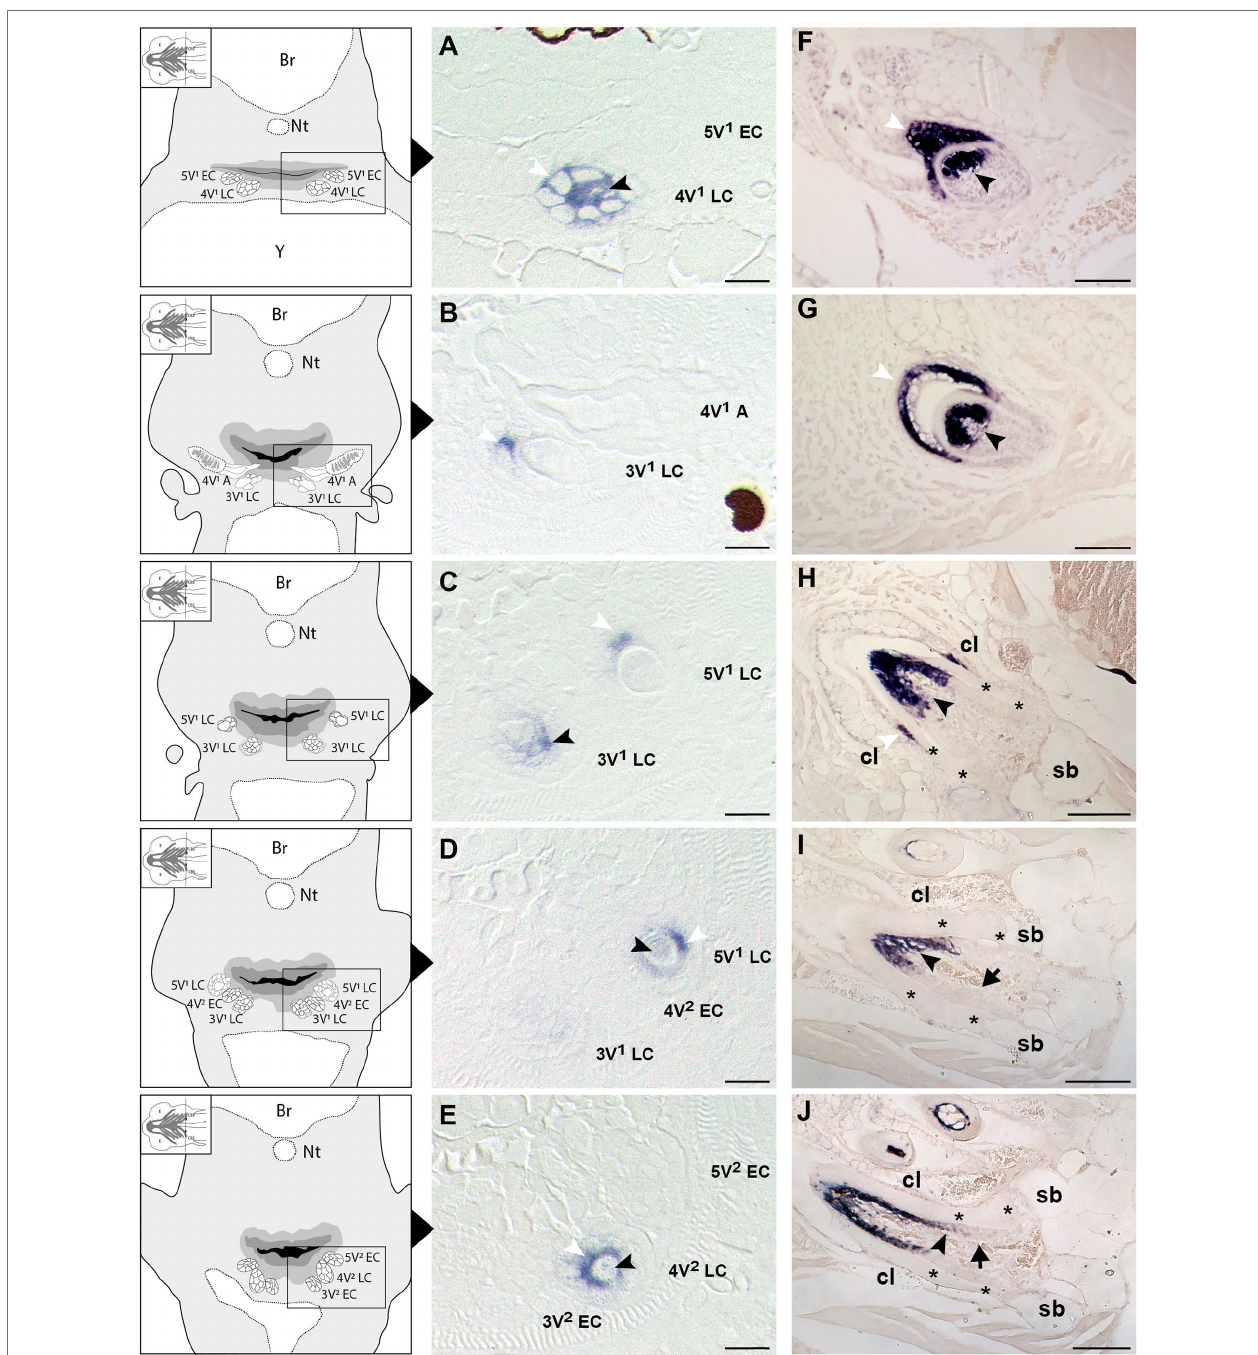
FIGURE 2 | Expression of secretory calcium-binding phosphoprotein 5 ( scpp5 ) during zebrafish tooth development. Transverse sections of zebrafish postembryonic stages (72–120 hpf – A–E ) and adults (F–J) in the region of the pharyngeal jaws, with explanatory schemes for postembryonic stages. At 72 hpf (A) the initiator tooth (4V 1 ) at LC stage expresses scpp5 in both ameloblasts and odontoblasts, whereas no expression is detected for the first-generation teeth 3V 1 and 5V 1 , still at EC stage. Between 80 (B) and 96 hpf (C) tooth 4V 1 , now attached, shows no expression of scpp5 , while 3V 1 and 5V 1 at LC stages start to express scpp5 in both ameloblasts and odontoblasts. Between 96 (D) and 120 hpf (E) the second-generation teeth (4V 2 , 3V 2 , and 5V 2 ) fail to express scpp5 during EC but upregulate expression in both ameloblasts and odontoblasts at LC. During the development of adult teeth, the expression of scpp5 is detected in both ameloblasts and odontoblasts at EC (F) , LC (G) and when the tooth starts to attach to bone (H) . Expression is restricted to odontoblasts when the tooth is completely attached [ (I) and (J) ]. Tooth developmental stages: A, phase of attachment; EC, early cytodifferentiation; LC, late cytodifferentiation. Br, brain; cl, cervical loop; Nt, notochord; sb, supporting bone; Y, yolk; asterisks, “bone of attachment”; arrows, cells forming “bone of attachment”; white arrowheads, ameloblasts; black arrowheads, odontoblasts. Scale bar (A-E) = 10 μ m, (F–G) = 50 μ m, (H–J) = 100 μ